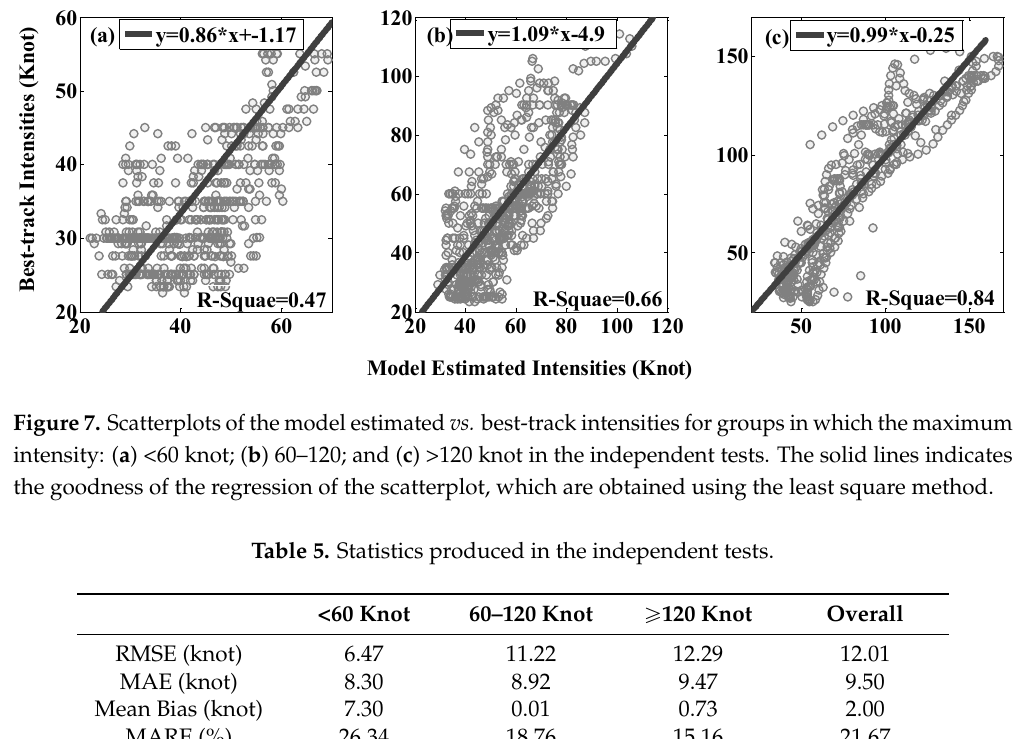
Figure 7. Scatterplots of the model estimated vs. best-track intensities for groups in which the maximum intensity: ( a ) <60 knot; ( b ) 60–120; and ( c ) >120 knot in the independent tests. The solid lines indicates the goodness of the regression of the scatterplot, which are obtained using the least square method.